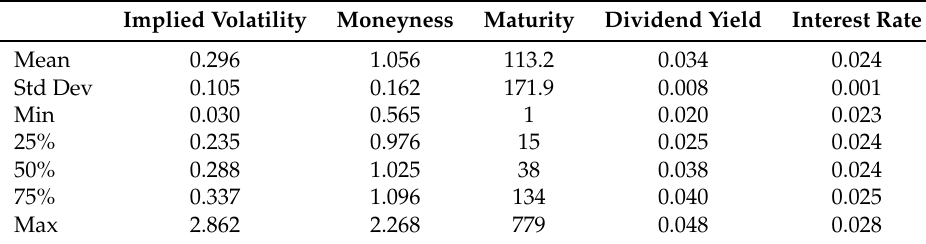
Table 1. Statistics on input variables.